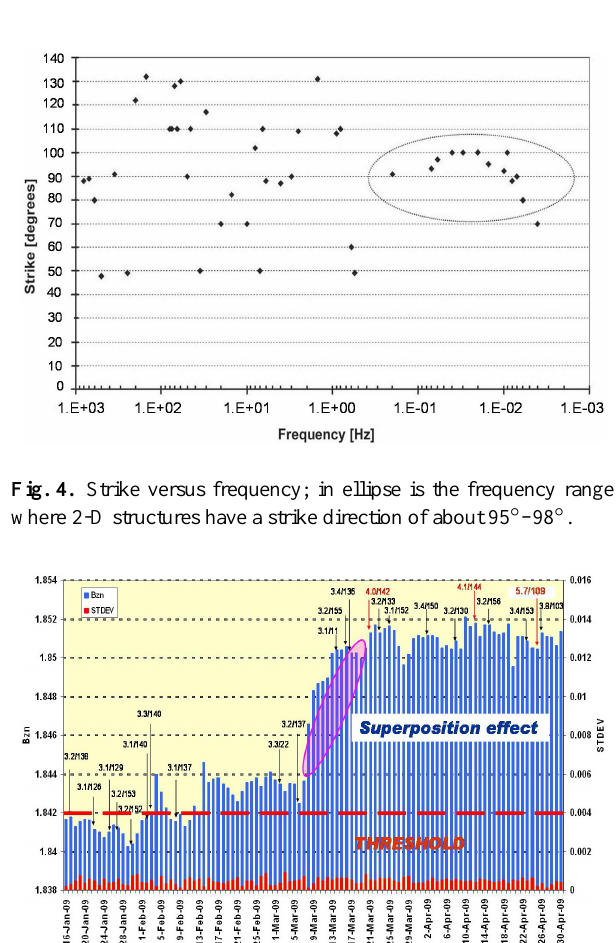
domain which started on 8 March, which may represent a su- perposition effect of the three earthquakes of magnitude 4.0, 4.1, and 5.7, that occurred on 21 March, 12 April, 25 April.